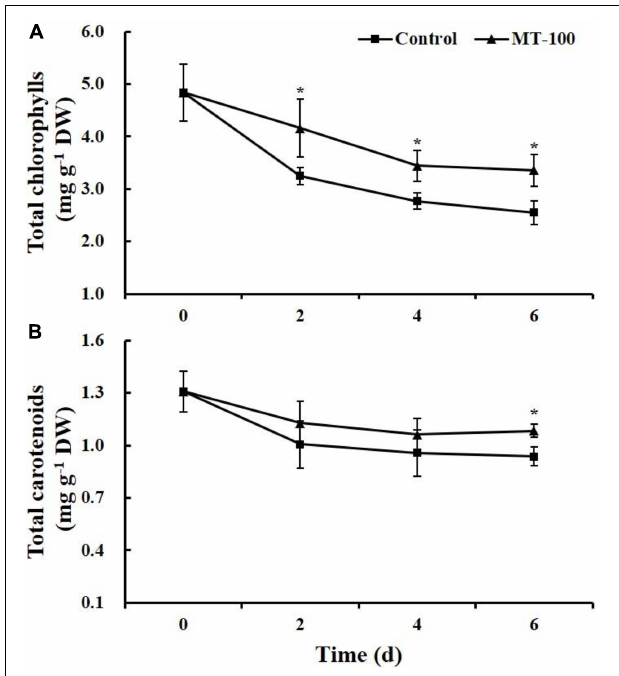
FIGURE 3 | Total chlorophyll (A) and carotenoid (B) content of 100 µ mol L − 1 melatonin treated lateral buds of baby mustard during storage at 20 ◦ C. MT-100, 100 µ mol L − 1 melatonin treatment. Each value is presented as the mean ± standard error of four biological replicates. Asterisks (*) indicate the significant differences ( P < 0.05) between control and melatonin-treated lateral buds during storage.